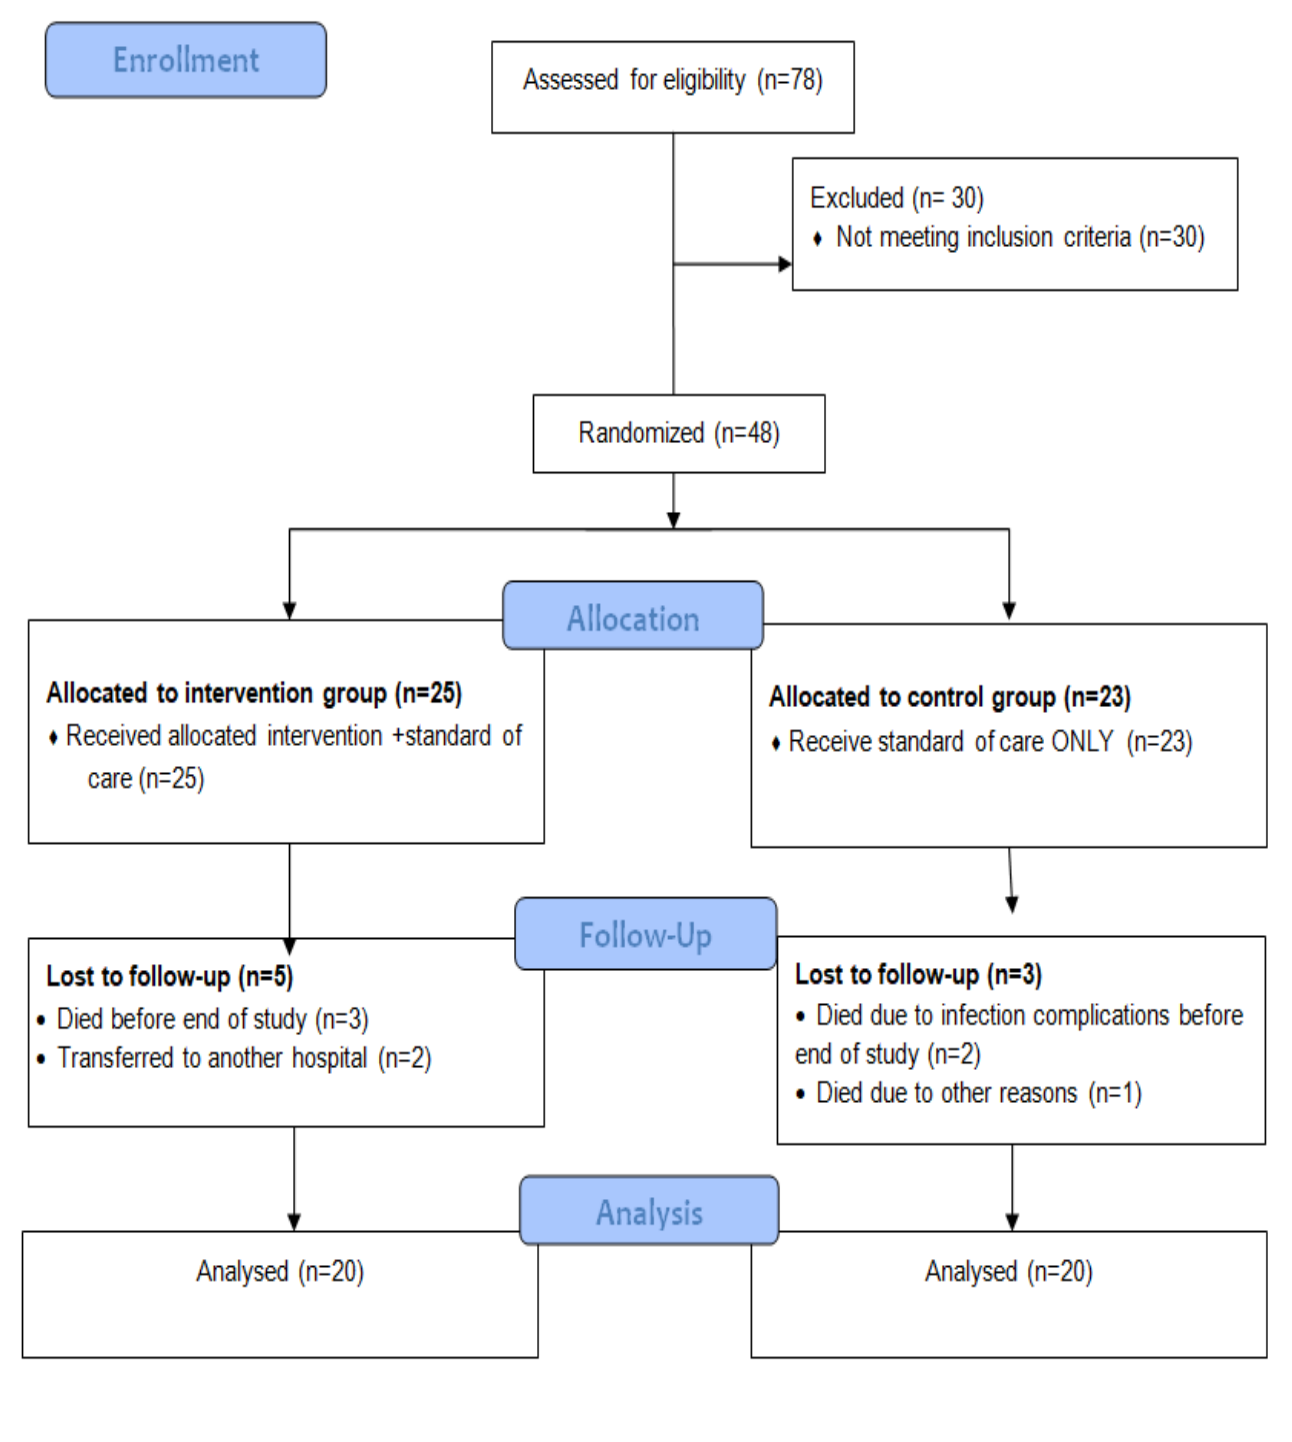
Fig. 1. CONSORT Flow